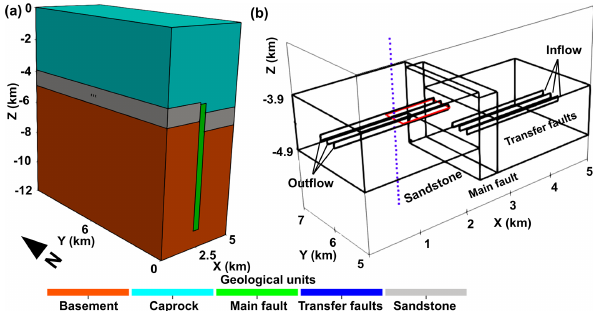
Figure 2. Model geometry of the (a) total model and (b) zoomed part of the sandstone reservoir where the transfer faults are embed- ded. The red rectangle, which is perpendicular to the main fault, represents the outline of the Piesberg quarry. The dashed purple line shown in (b) is used to illustrate the extent of the temperature-depth